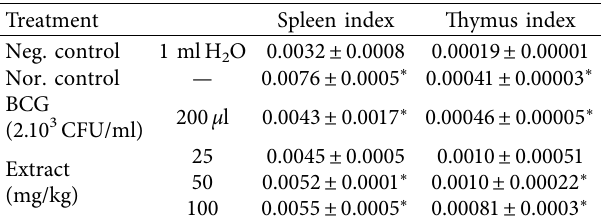
Neg. control: prednisolone-treated animal and receiving the vehicle (saline solution) and Nor. control: normal control. Asterisks ( ∗ p < 0 . 05, ∗∗ p < 0 . 01, and ∗∗∗ p < 0 . 001) indicate the significant difference as compared to negative